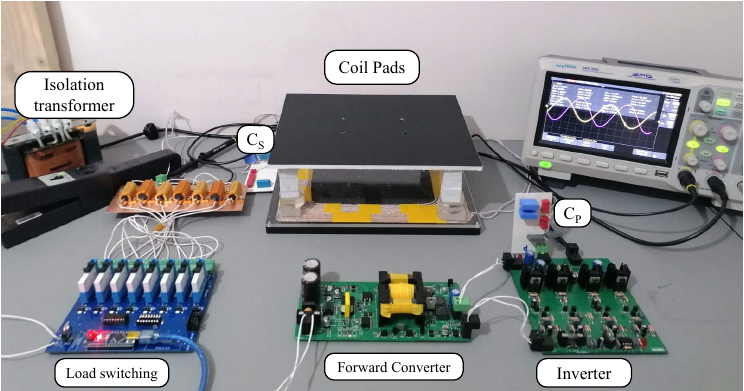
Figure 6. Experimental setup of the primary ‐ side controlled IPT.